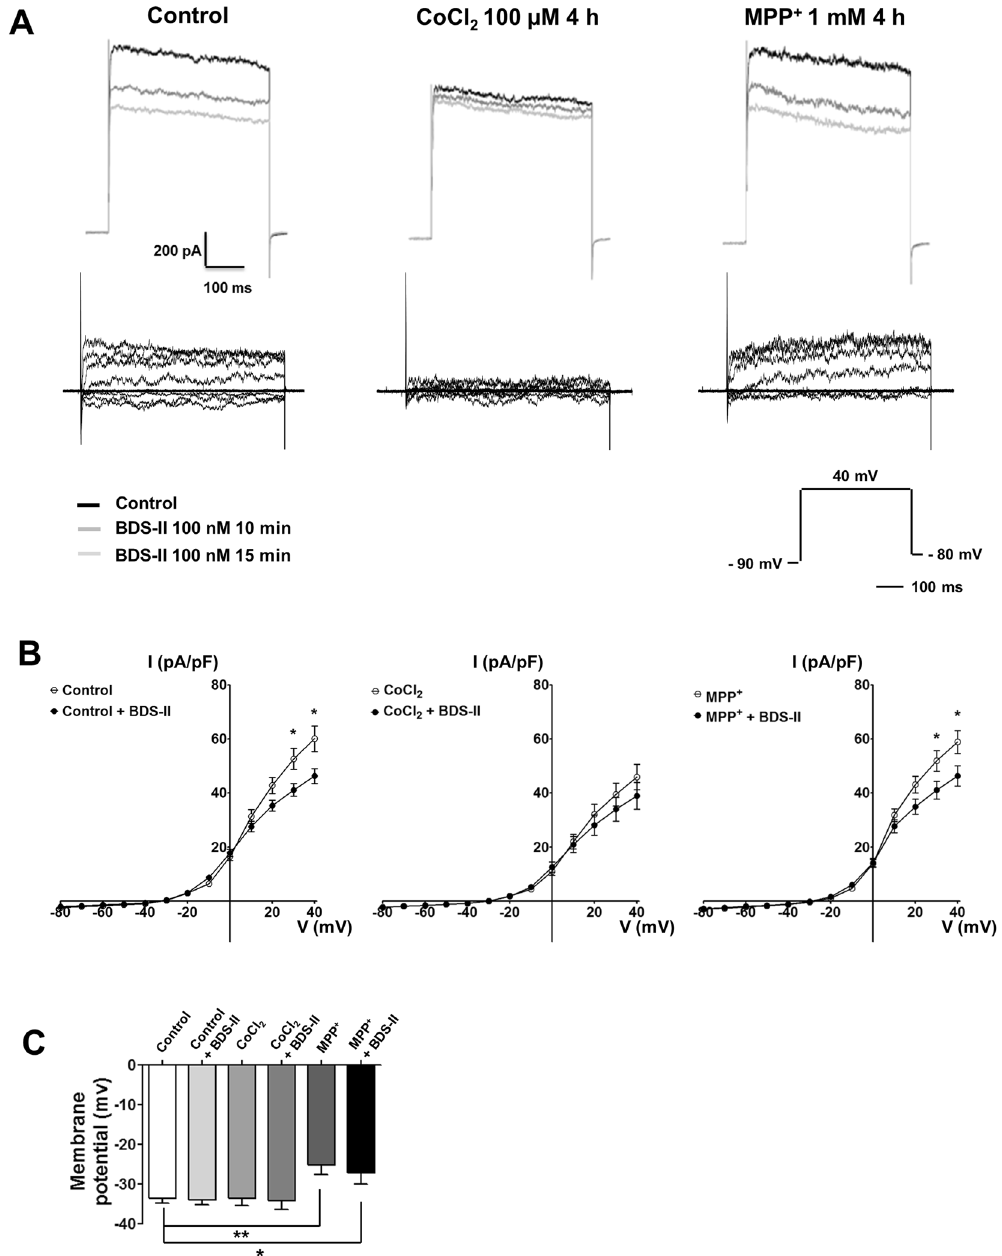
Figure 2. Patch-clamp recordings of BDS-II-sensitive currents during CoCl 2 or MPP + treatment ( A ) Representative whole-cell currents recorded in SH-SY5Y cells. Currents sensitive to BDS-II (100 nM) were measured in whole-cell mode. SH-SY5Y cells were hyperpolarized by a − 90 mV pulse and then depolarized by a + 40 mV pulse with a − 80 mV holding potential. After 10 min of BDS-II treatment, diminished currents were observed in the control group (327.62 ± 83.45 pA, n = 12), the 100 µ M CoCl 2 -treatment group (138.89 ± 51.8 pA, n = 8), and the 1 mM MPP + -treatment group (253.3 ± 47.98 pA, n = 9). ( B ) BDS-II significantly inhibited voltage-dependent currents at + 30 and + 40 mV of depolarization in the control group and 1 mM MPP + -treatment group, whereas no BDS-II-sensitive current was detected in cells treated with 100 µ M CoCl 2 . Experiments were repeated at the indicated times, and data are expressed as the mean ± standard error. * p < 0.05 and *** p < 0.001 versus the control value. ( C ) The resting membrane potential of SH-SY5Y cells was significantly depolarized by 1 mM MPP + treatment. However, 100 nM BDS-II did not affect the resting membrane